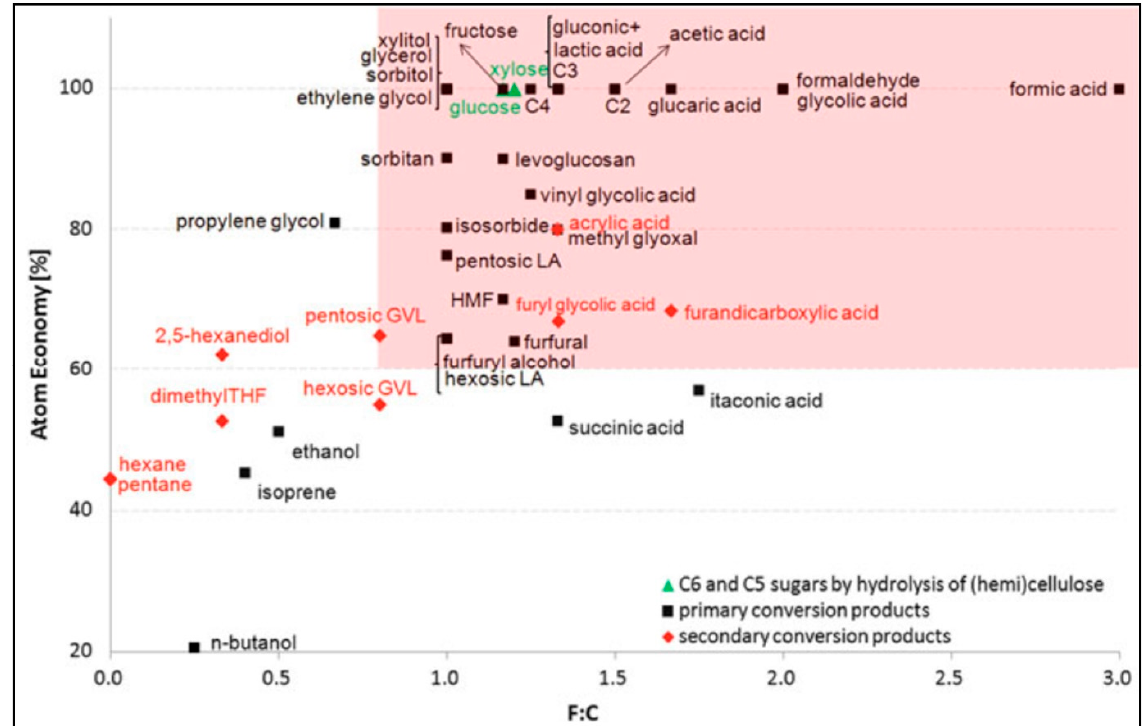
Figure 5. Graphical representation of the atom economy vs. F:C for common carbohydrates and their derivatives. Graph and data are reproduced with the permission of Springer (based on Dusselier et al., 2014, pp. 1–40) [112].